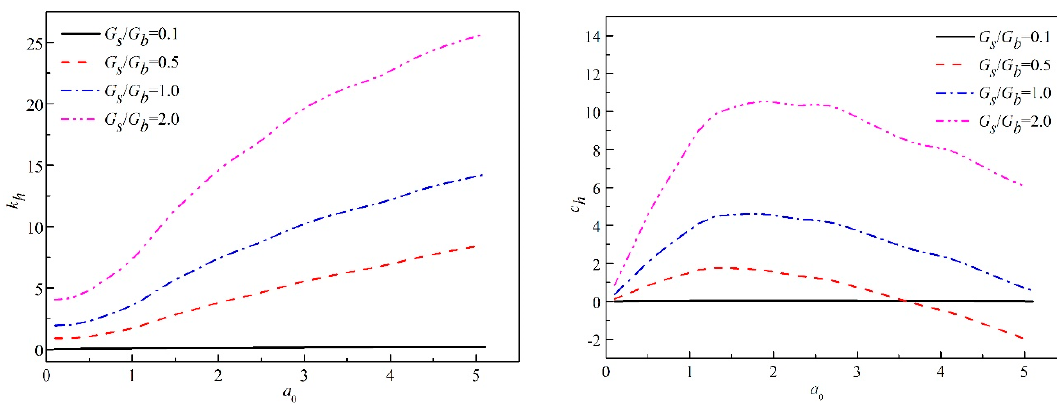
Figure 10. Horizontal dynamic impedance of embedded foundation under different soil stiffness.